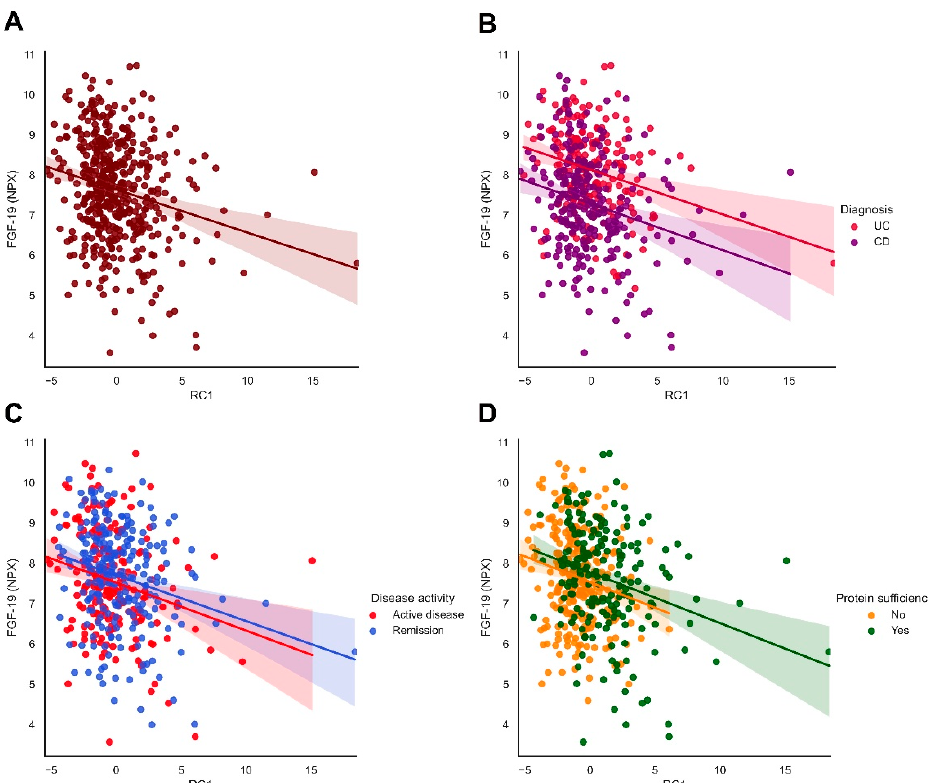
Figure 3. Plasma FGF-19 levels are strongly associated with the first dietary pattern (PC1), mainly representing a diet rich in refined carbohydrates. ( A ) Plasma FGF-19 levels are inversely correlated with RC1. ( B – D ) The association between plasma FGF-19 levels and RC1 remained robust throughout all analyses, including when stratified by diagnosis (CD or UC, panel B), disease activity (panel C) or protein intake (panel D). Abbreviations: CD, Crohn’s disease; FGF-19, fibroblast growth factor-19; RC1, rotated component 1; UC, ulcerative colitis.